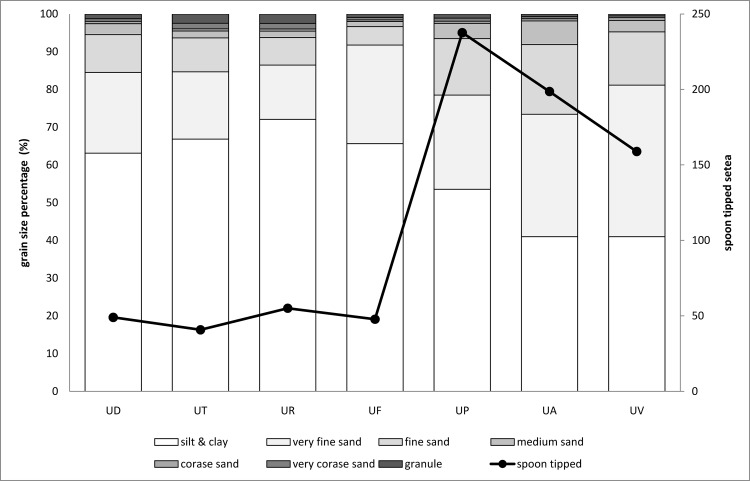
The percentage of grain size in sediment texture and mean number of spoon tipped setae in seven species of fiddler crabs with the average carapace width of 15mm.UD = U. paradussumieri, UT = U. triangularis, UR = U. rosea, UF = U. forcipata, UP = U. perplexa, UA = U. annulipes, UV = U. vocans.